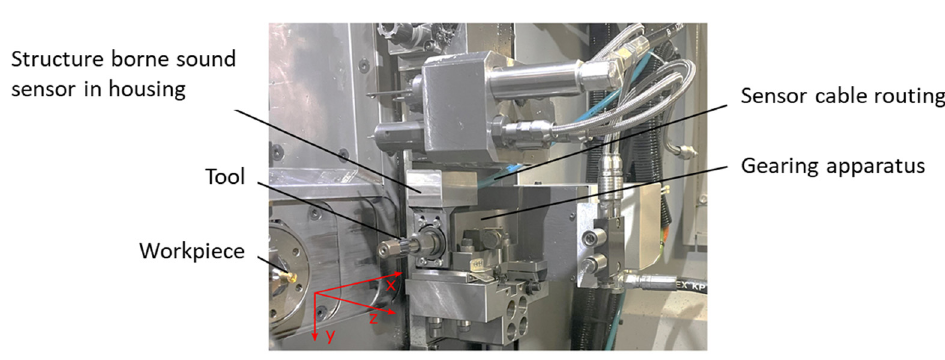
Figure 4. Sensor integration in the